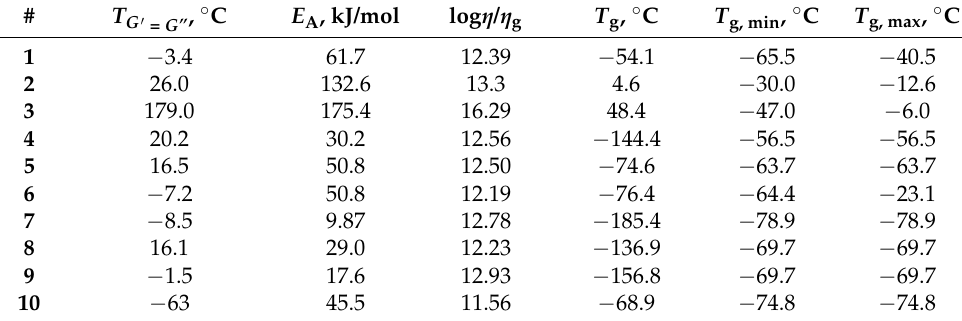
Table 3. Temperature characteristics of